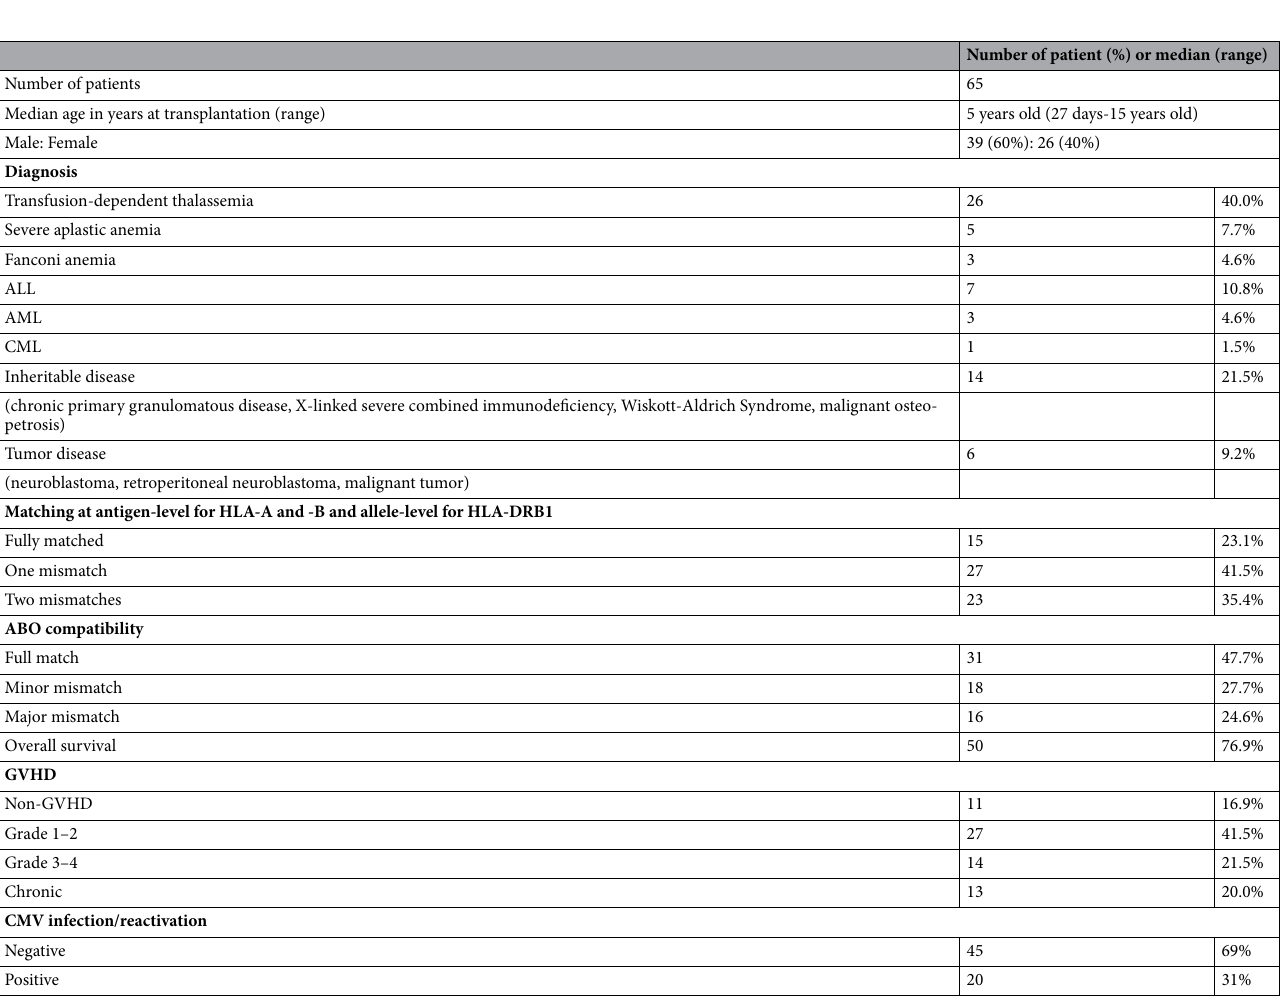
Table 1. Characteristics of patients receiving unrelated CBT.